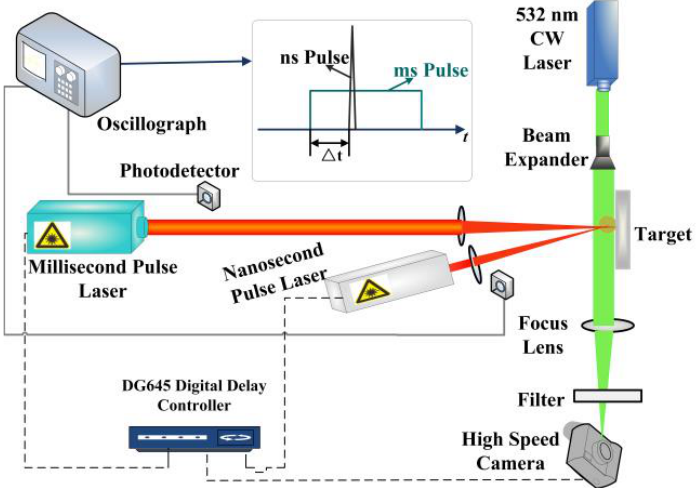
Figure 1. The experiment setup of ms-ns CPL irradiating silicon. A digital delay generator DG645 can not only control the ms laser and high-speed camera to be triggered at the same time, but also set the pulse delay of the ms-ns CPL. The oscillograph and photodetector are used to monitor the pulse delay. The ns laser energy density ( D ns ) is fixed at 12 J/cm 2 . The energy densities of the ms laser ( D ns ) are 226.13 J/cm 2 , 301 J/cm 2 , 376.88 J/cm 2 , and 414.58 J/cm 2 . The pulse delay ( ∆ t ) is defined as the time that the ns laser lags behind the ms laser. The starting time of ms laser irradiation is defined as 0 s. The range of pulse delay is 0 to 3 ms, and the interval is 0.2 ms. The silicon, with radius of 12.7 mm and thickness of 4 mm, is used as the target. The experiment is carried out at 20 ◦ C in air.